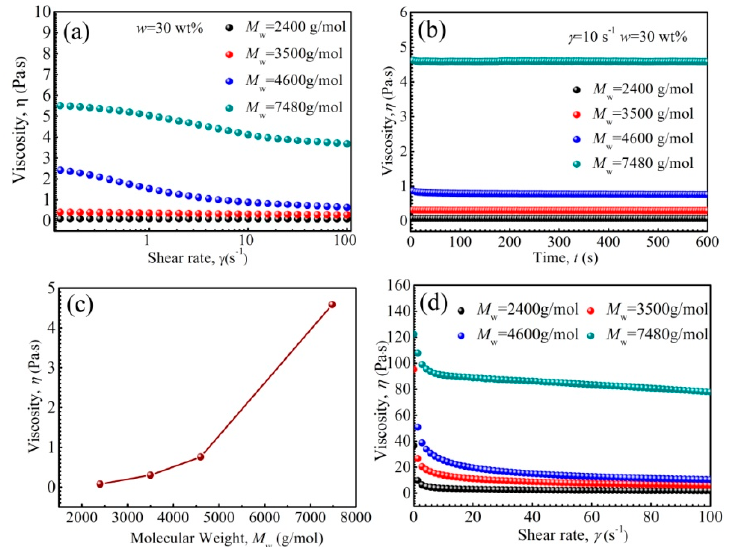
Figure 5. The viscosity of ferrofluids as a function of shear rate ( a ), shear time ( b ), PFPE oil M w ( c ), and the viscosity of the fluids as a function of shear rate at 10 mT ( d ).